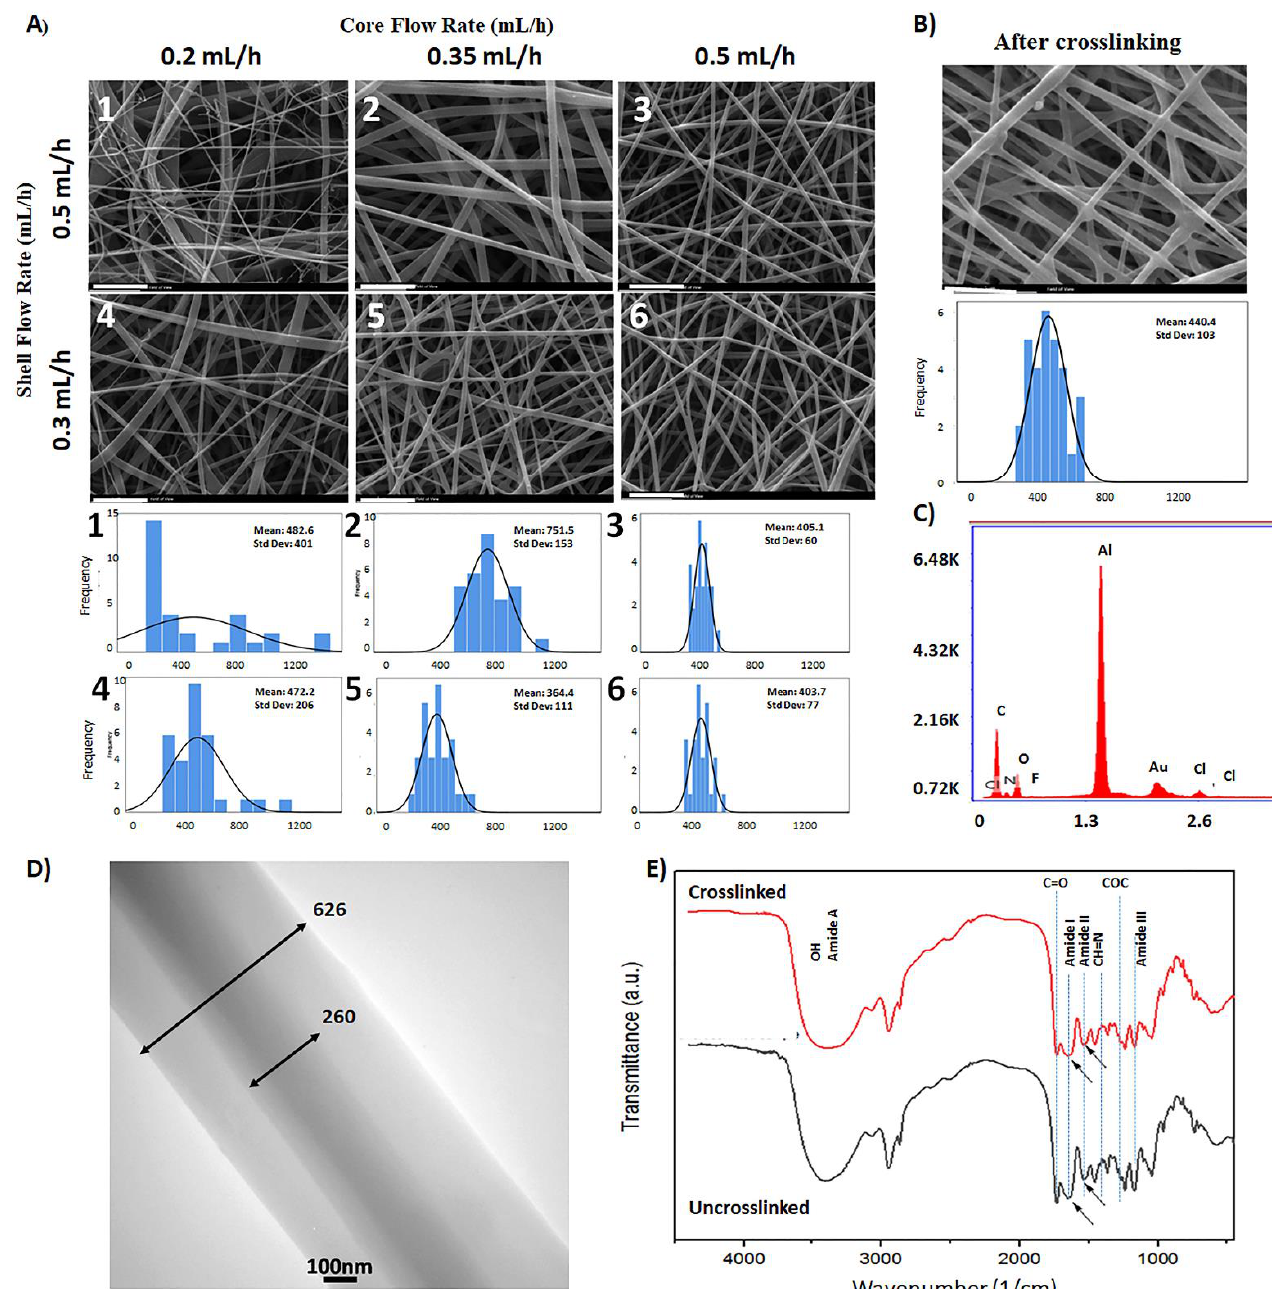
Figure 1. The morphological and chemical study; ( A ) t he SEM micrographs (scale bar = 5 μm), and the fiber diameter distribution of the prepared samples at different flow rates of the core and